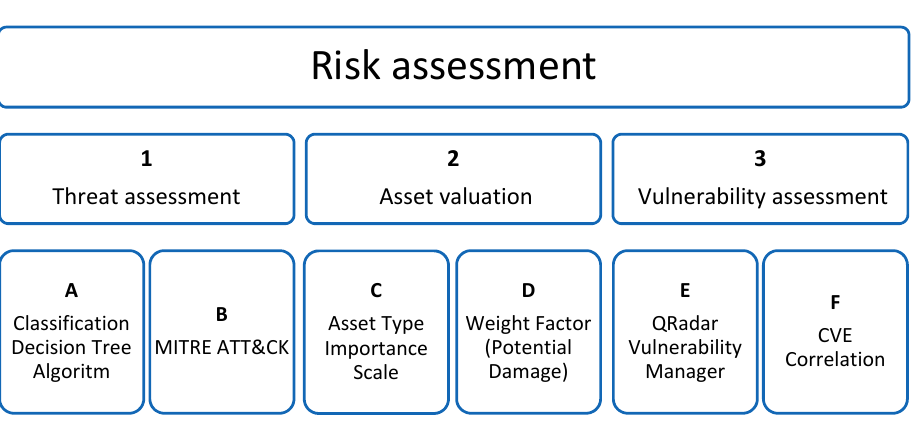
Figure 5. Decision Tree intelligent risk assessment.